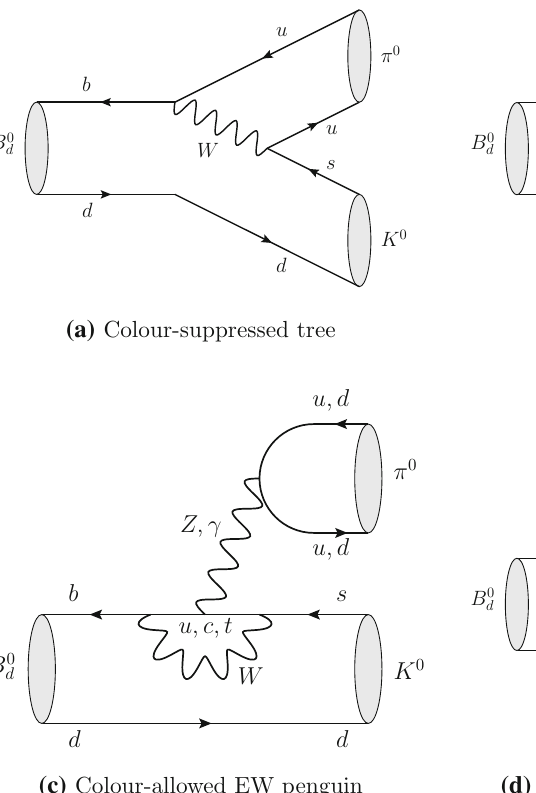
Fig. 1 Topologies contributing to the B 0 as colour-allowed tree amplitudes, contributing O ( 10% )